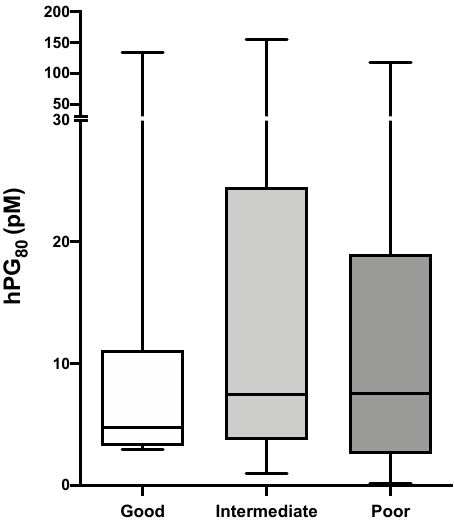
Figure 4. hPG 80 levels according to the IMDC score. hPG 80 levels in mRCC patients according to the good-, intermediate- and poor-risk IMDC risk classification. One-tailed Mann-Whitney test; ns: not significant. Table 3. hPG 80 levels according to the IMDC score in mRCC patients.